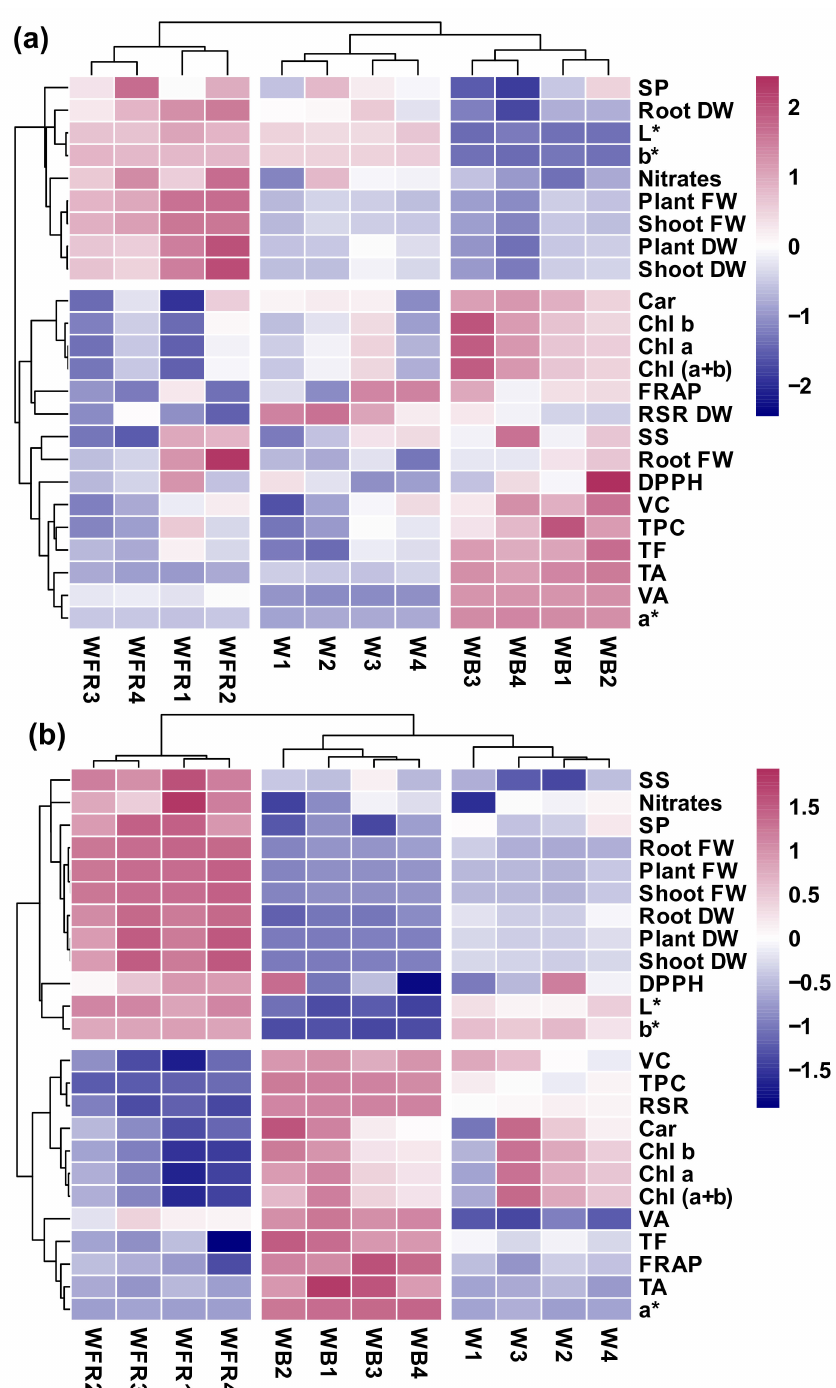
Figure 3. The heat map analysis of overall quality of two lettuce cultivars. The clustered heat map of ( a ) “Yanzhi” and ( b ) “Red Butter”. FW = fresh weight, DW = dry weight, L* = lightness, a* = redness, b* = yellowness, Chl = chlorophyll, Car = carotenoids, TA = total anthocyanins, DPPH = DPPH radical inhibition percentage, FRAP = ferric ion reducing antioxidant power, TF = total flavonoids, TPC = total phenolic compounds, SP = soluble proteins, SS = soluble sugars, RSR = root to shoot ratio, W = equalized-white light; WFR = W plus far-red light; WB = W plus blue